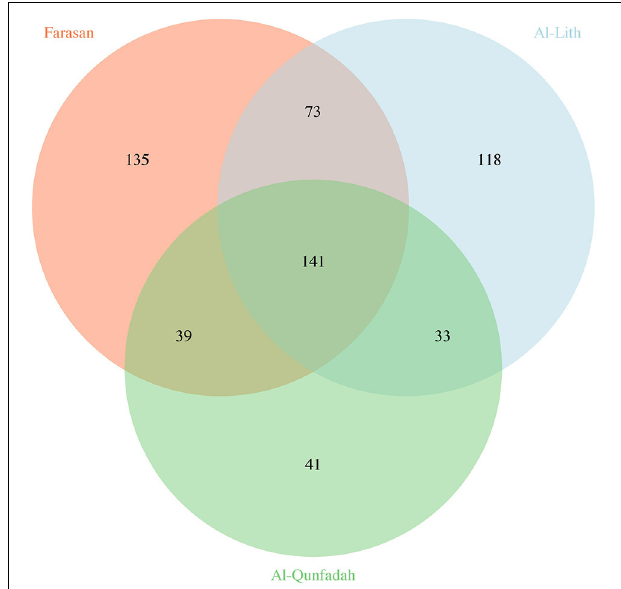
FIGURE 3 | Number of unique and shared OTUs observed across the three